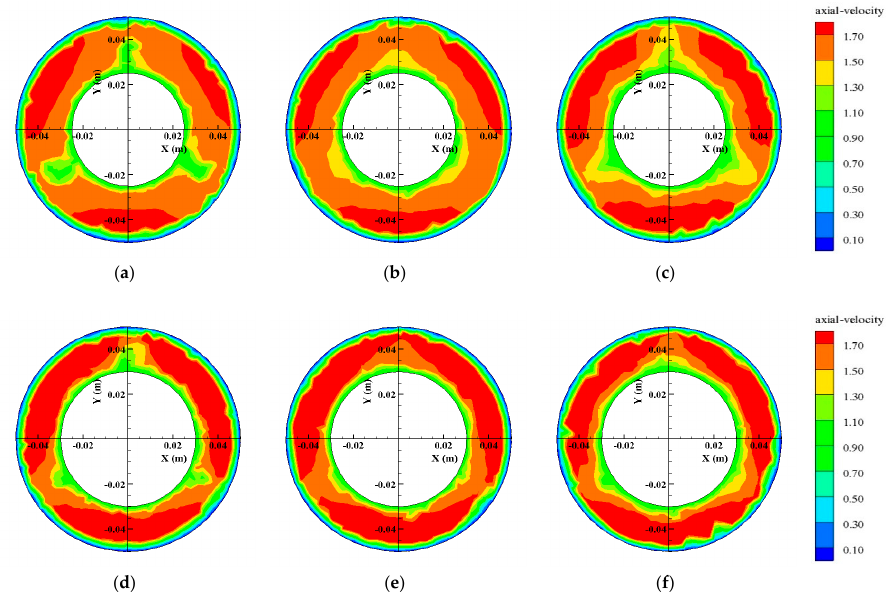
Figure 13. Axial flow velocity distribution of annular gap sections of the capsule: ( a ) front section, L/D = 2; ( b ) middle section, L/D = 2; ( c ) rear section, L/D = 2; ( d ) front section, L/D = 1.67; ( e ) middle L / D = 2; ( b ) middle section, L / D = 2; ( c ) rear section, L / D = 2; ( d ) front section, L / D = 1.67; ( e ) middle section, L / D = 1.67; ( f ) rear section, L / D =